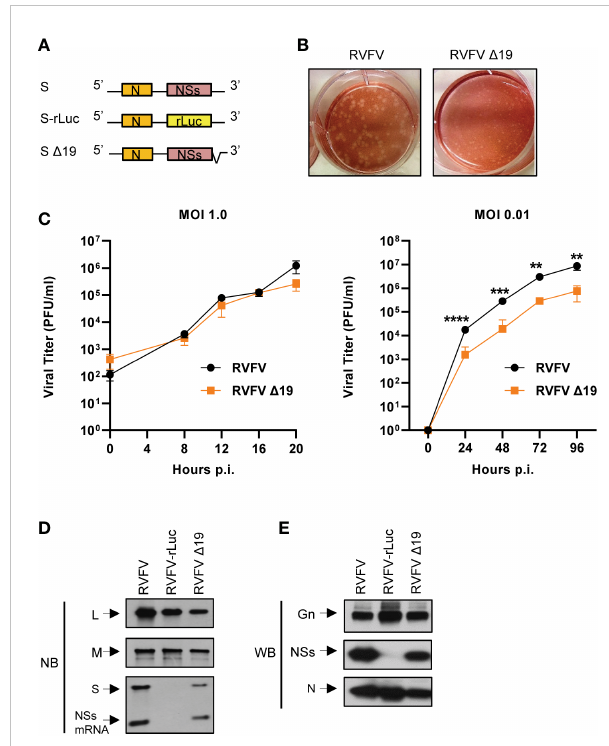
FIGURE 4 Rescue and characterization of RVFV D 19. (A) Schematic diagram of S RNA and S RNA mutants in the antigenomic sense. S-rLuc RNA contains the rLuc ORF in place of the NSs ORF. S D 19 RNA contains a deletion of 19 nt in the 3 ’ -terminal NCR of the antigenomic S RNA. (B) Plaque morphologies of RVFV and RVFV D 19 in Vero E6 cells. (C) Growth curves of RVFV and RVFV D 19 in Huh7 cells. Huh7 cells were infected with RVFV or RVFV D 19 at an MOI of 1.0 (left panel) or an MOI of 0.01 (right panel). Culture supernatants were collected at the indicated time points and the virus titers were determined in Vero E6 cells by plaque assay analysis. The data were obtained from three independent experiments. The values are mean titers and error bars indicate standard deviation. ** P < 0.01, *** P < 0.001, **** P < 0.0001. (D) Accumulation of viral RNAs in infected cells. Huh7 cells were infected with RVFV, RVFV-rLuc, or RVFV D 19 at an MOI of 3. Total intracellular RNAs were extracted at 8 h p.i and equal amounts of intracellular RNAs were analyzed by Northern blot (NB) using digoxigenin-labeled RNA probes that speci fi cally bind to the respective genomic RNA segments. The RNA probe to detect genomic S binds within the NSs ORF resulting in detection of full- length S RNA as well as NSs mRNA. (E) Accumulation of viral proteins in infected cells. Huh7 cells were infected with RVFV, RVFV- rLuc or RVFV D 19 at an MOI of 3. Cell lysates were collected at 8 h p.i. using the same amount of sample buffer and subjected to Western blot (WB) analysis using anti-Gn antibody (top panel), anti- NSs antibody (middle panel) and anti-N antibody (bottom